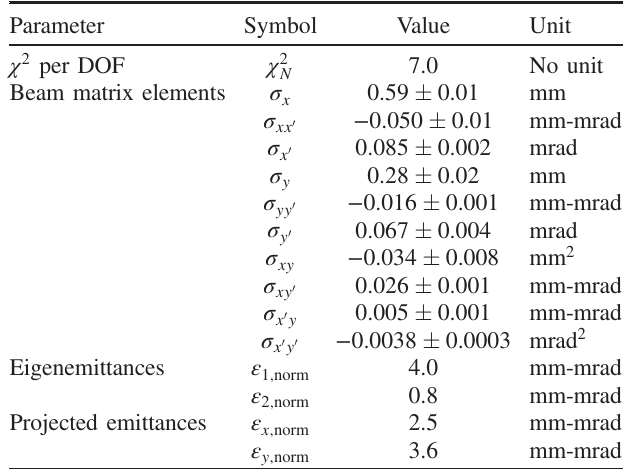
TABLE IV. Fit results beam